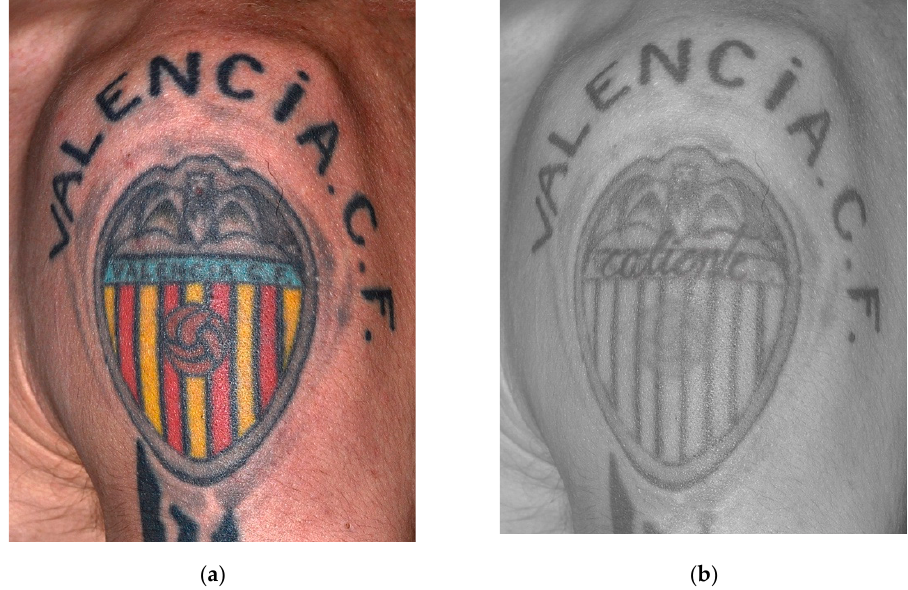
Figure 9. Images of tattooed shoulder: ( a ) captured with a conventional camera and illuminated with white visible light, and ( b ) captured by Invespector and illuminated with IR radiation 850 nm.